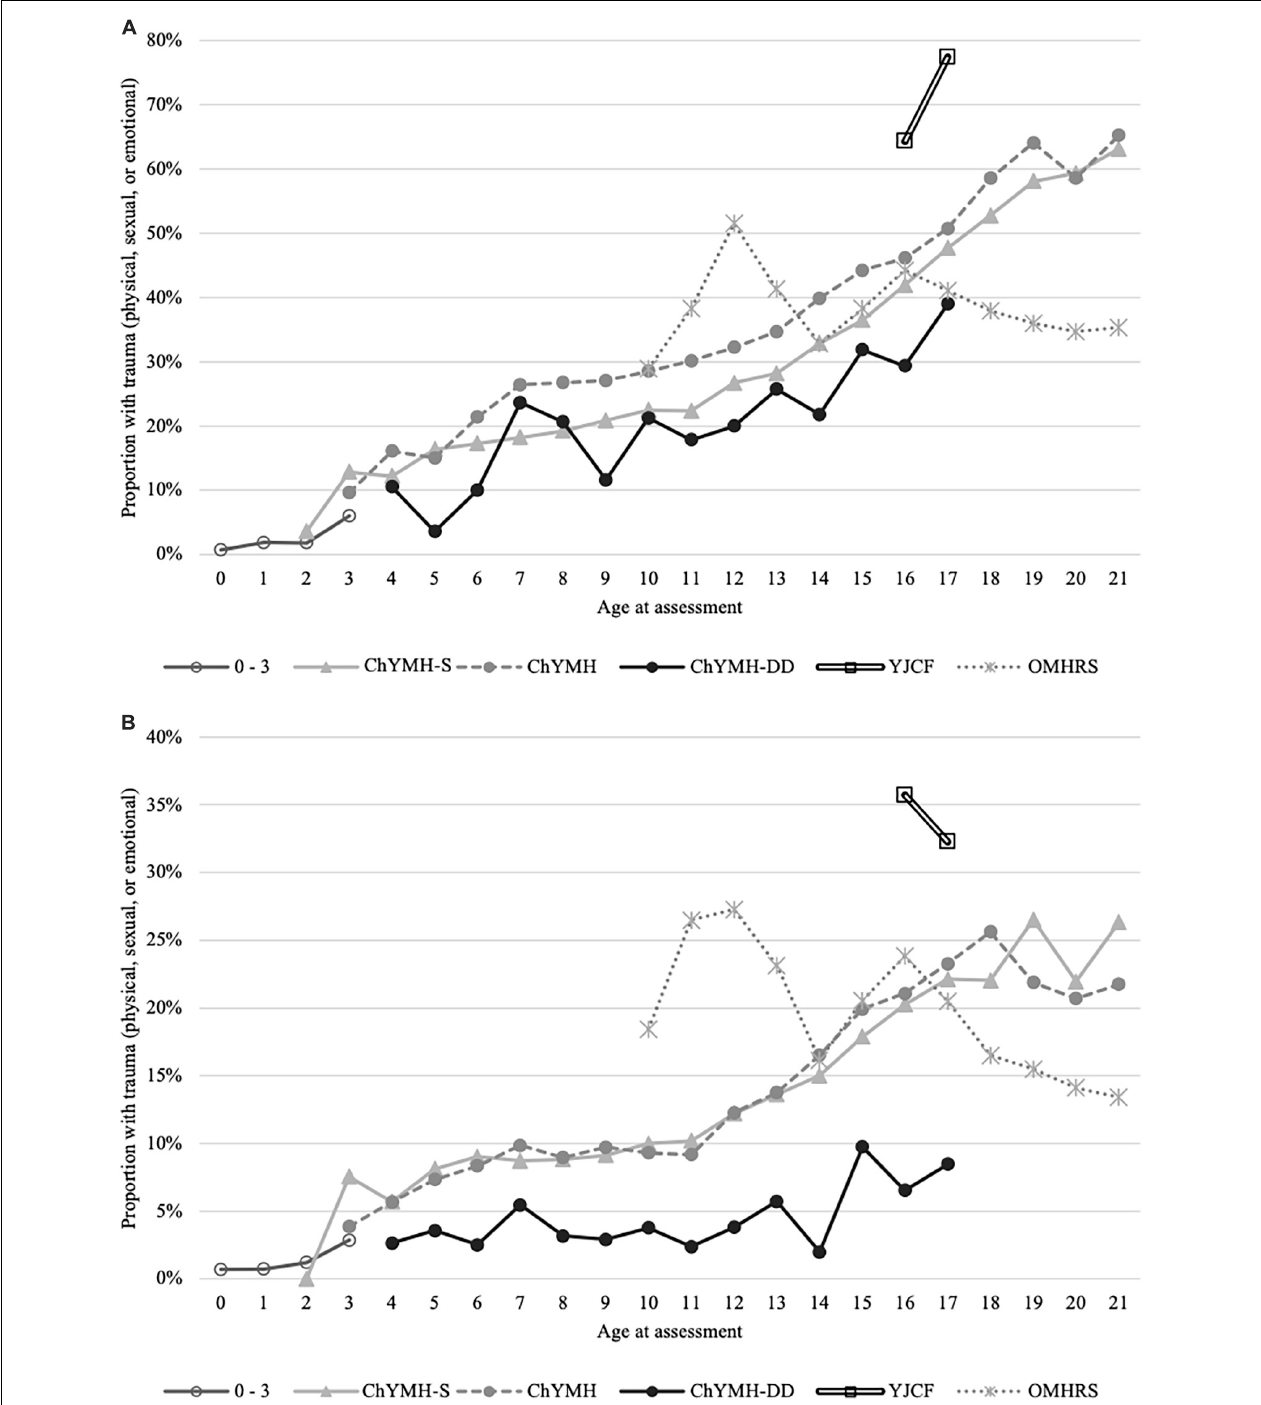
FIGURE 1 | (A) Lifetime trauma: victim of sexual assault or abuse, physical assault or abuse, or emotional abuse at any time. (B) Trauma in the last year: victim of sexual assault or abuse, physical assault or abuse, or emotional abuse within the last year.